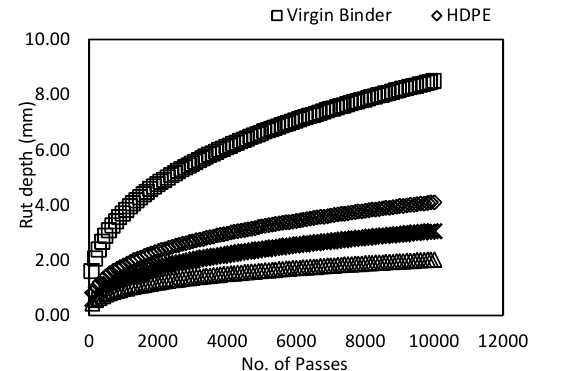
Fig. 7: Copper Wheel Tracker Test